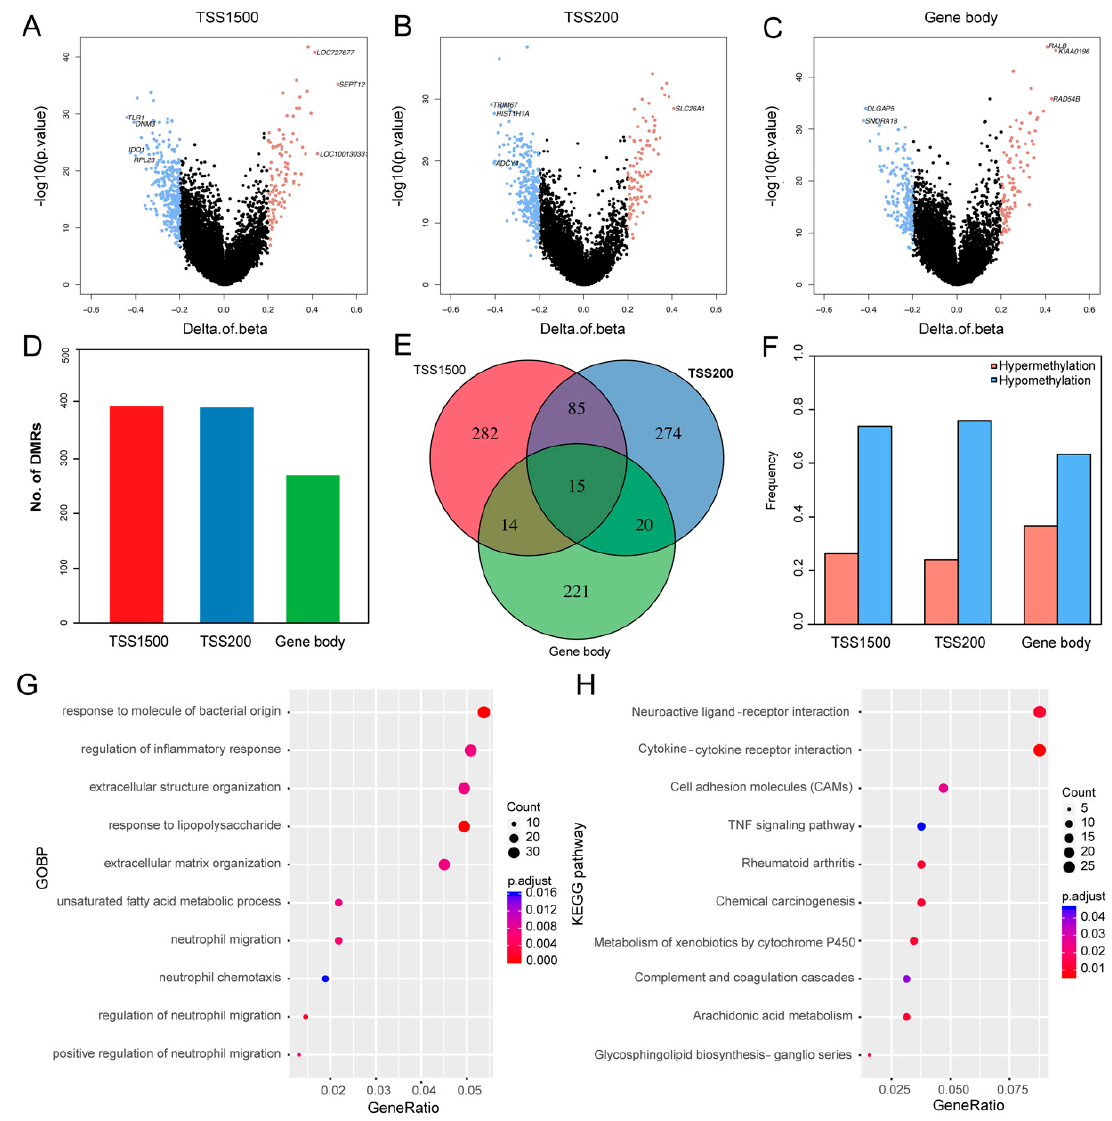
Di ff erentially methylated genes (DMGs) in triple-negative breast cancer (TNBC). ( A – C ) Volcano plots showing the distributions of DMGs in TSS1500, TSS200, and gene body regions. The red and blue dots represent the significantly hyper- and hypomethylated DMGs. ( D ) Bar plot showing the numbers of DMGs in TSS1500 ( n = 396), TSS200 ( n = 394), and gene body ( n = 270) regions. ( E ) Venn plot showing the intersections of DMGs between the three regions. Only 15 genes were di ff erentially methylated in all three regions, although there were numerous region-specific DMGs in TSS1500 ( n = 282), TSS200 ( n = 274), and gene body ( n = 221). ( F ) Bar plots showing the proportions of methylation in the three regions. ( G ) The top 10 Gene Ontology Biological Process (GOBP) terms in the three regions. ( H ) The top 10 Kyoto Encyclopedia of Genes and Genomes (KEGG) pathways in the three regions.